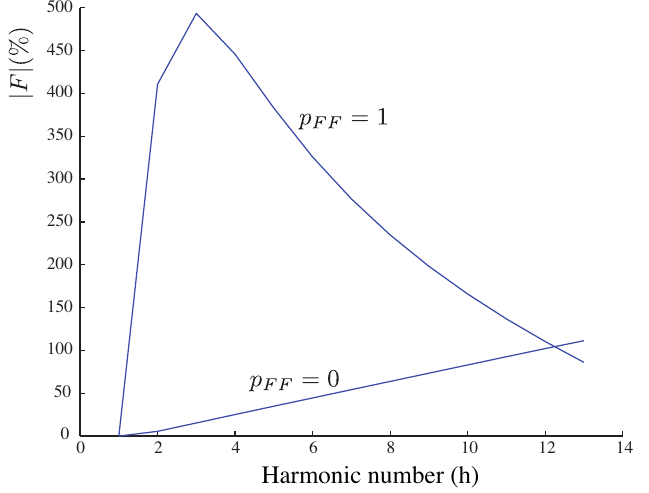
Figure 8. Current error relative to the current reference, as a function of the harmonic number, when using ( p FF = 0) or not ( p FF = 1) grid-voltage